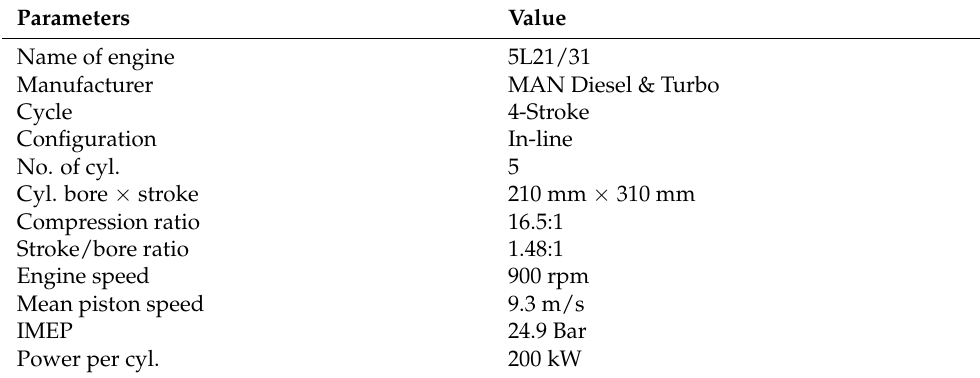
Table 1. Main specifications of the researched engine.